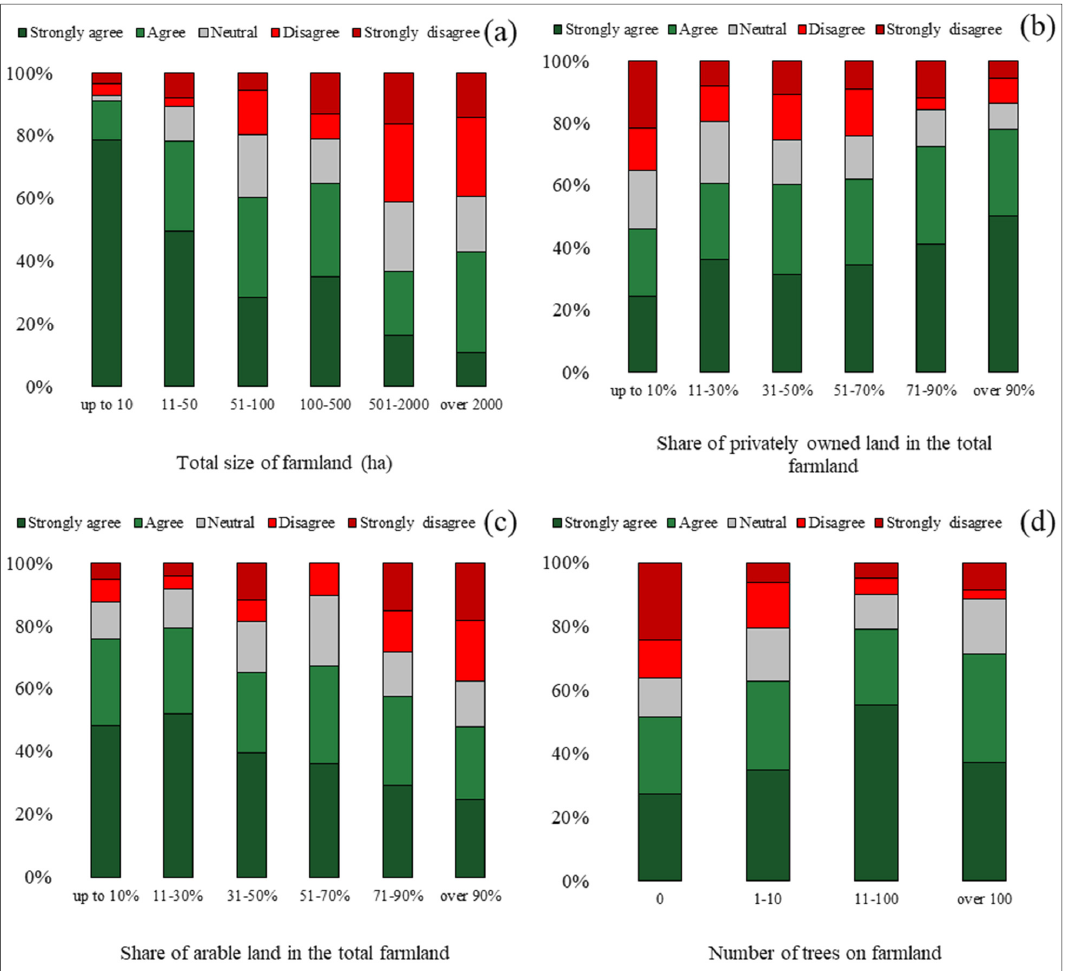
Figure 3. The willingness of farmers to establish AF based on ( a ) total size of farmland, ( b ) share of privately owned land in the total farmland, ( c ) share of arable land in the total farmland, ( d ) number of trees on farmland.